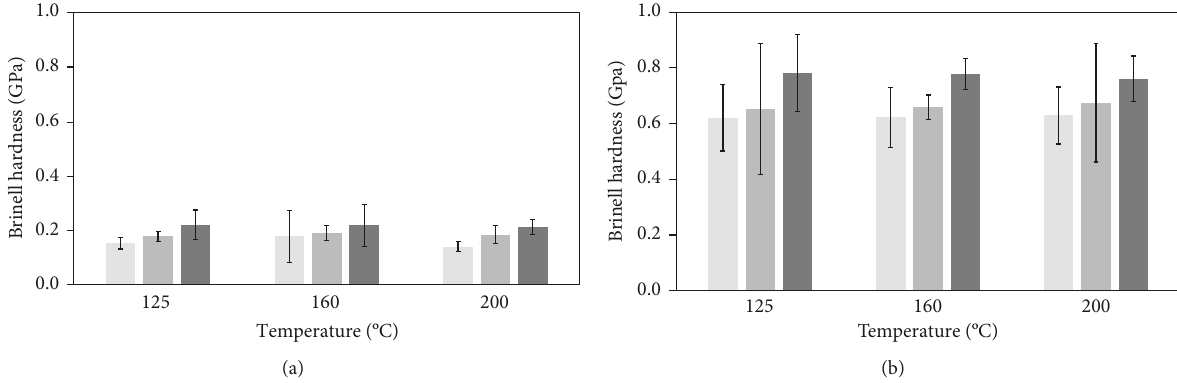
Figure 5: Brinell hardness after TMA for 0 wt.% B (light gray), 2.08 wt.% B (light-dark gray), and 4.17 wt.% B (dark gray) at 125 ° C, 160 ° C, and 200 ° C for (a) 5 wt.% Zn and (b) 10 wt.% Zn.